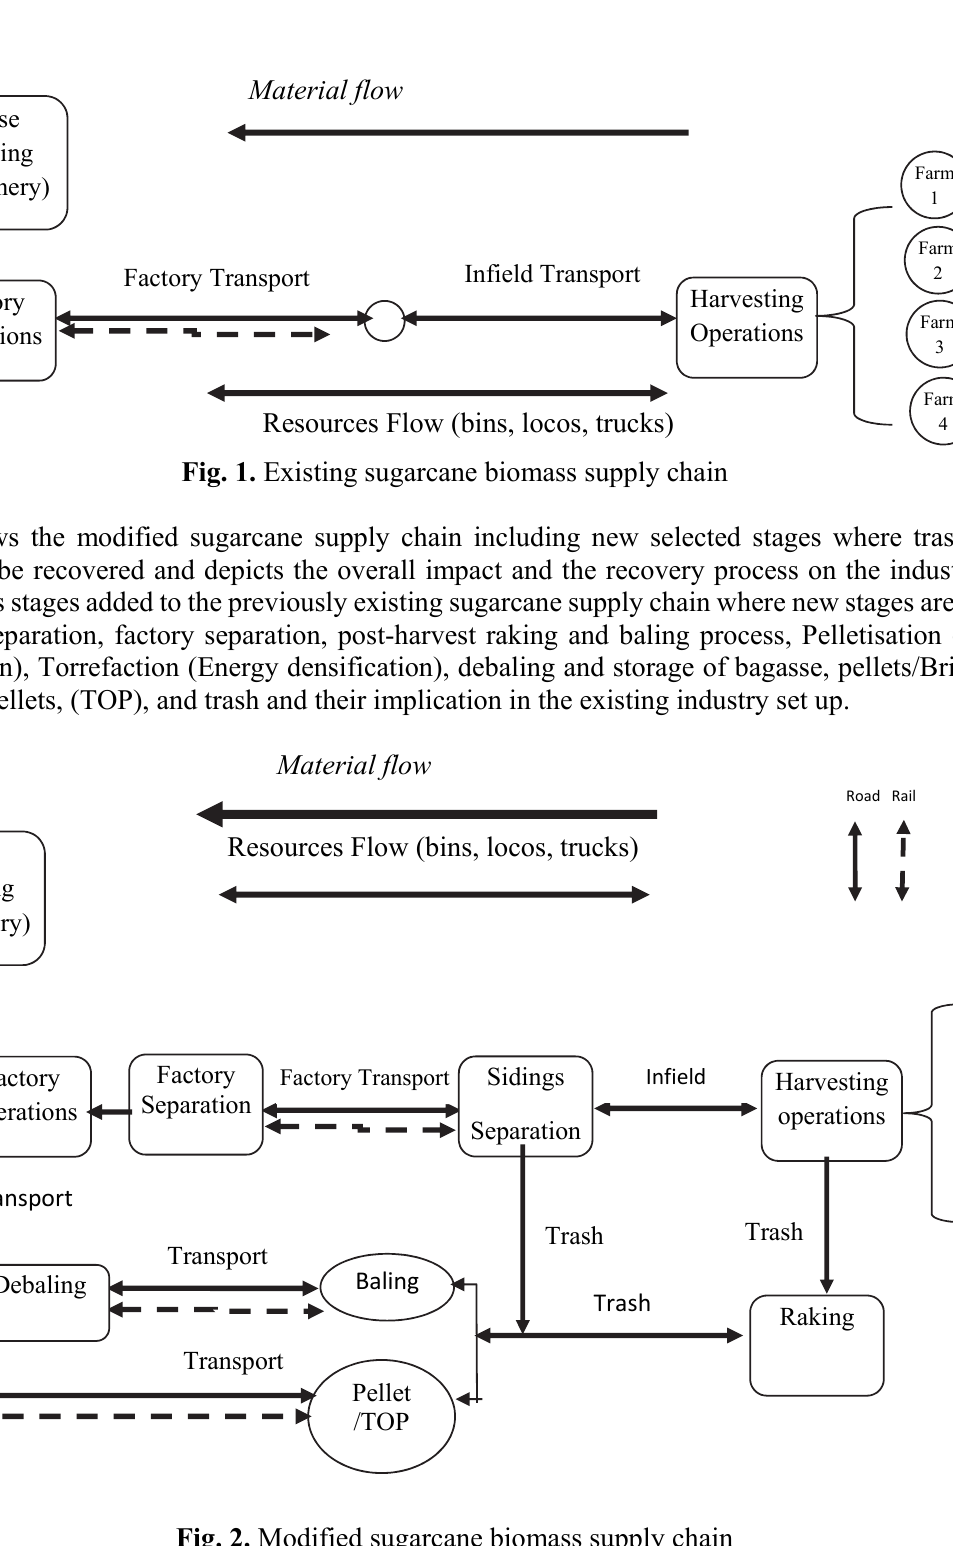
Fig. 2. Modified sugarcane biomass supply